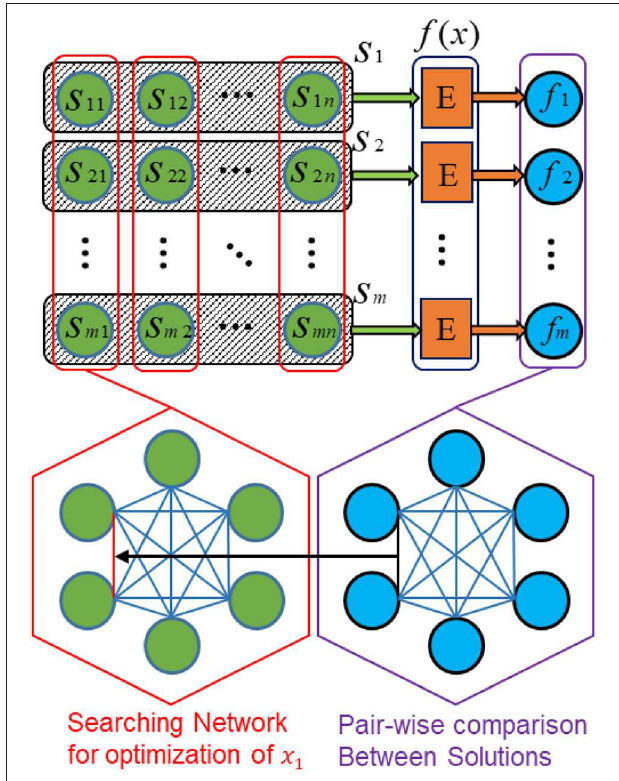
FIGURE 4 | SI-SNN architecture for parameter optimization of continuous functions.